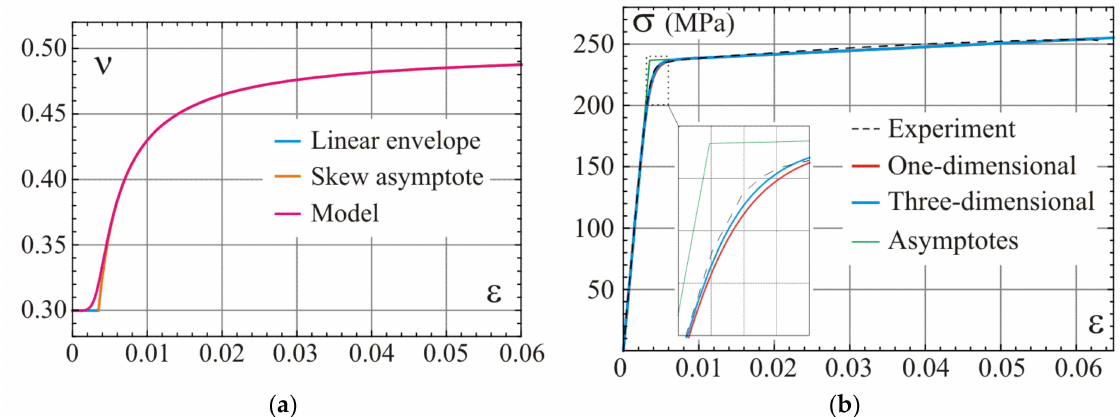
Figure 5. ( a ) Poisson’s ratio for the model and its envelope, ( b ) stress–strain relation for the one-dimensional and the uniaxial tension of the three-dimensional model with